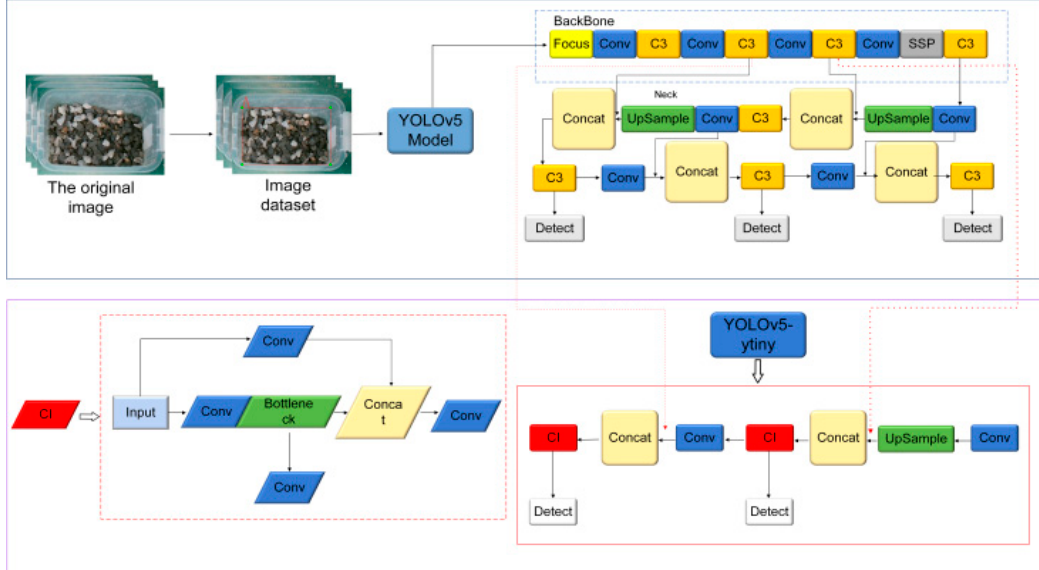
Figure 4. Improvements to YOLOv5 model.